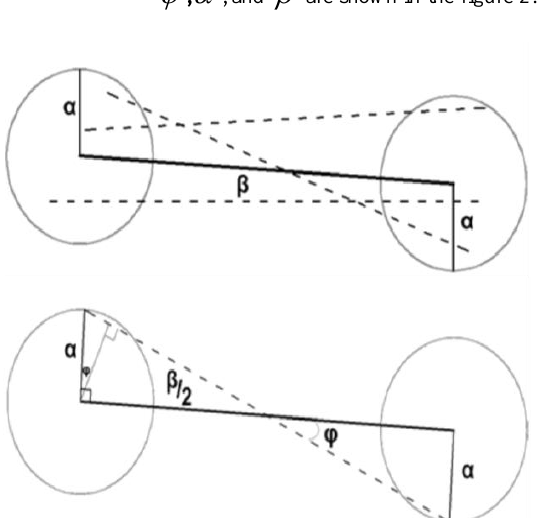
Figure 2: Possible and worst case scenario for the calculation